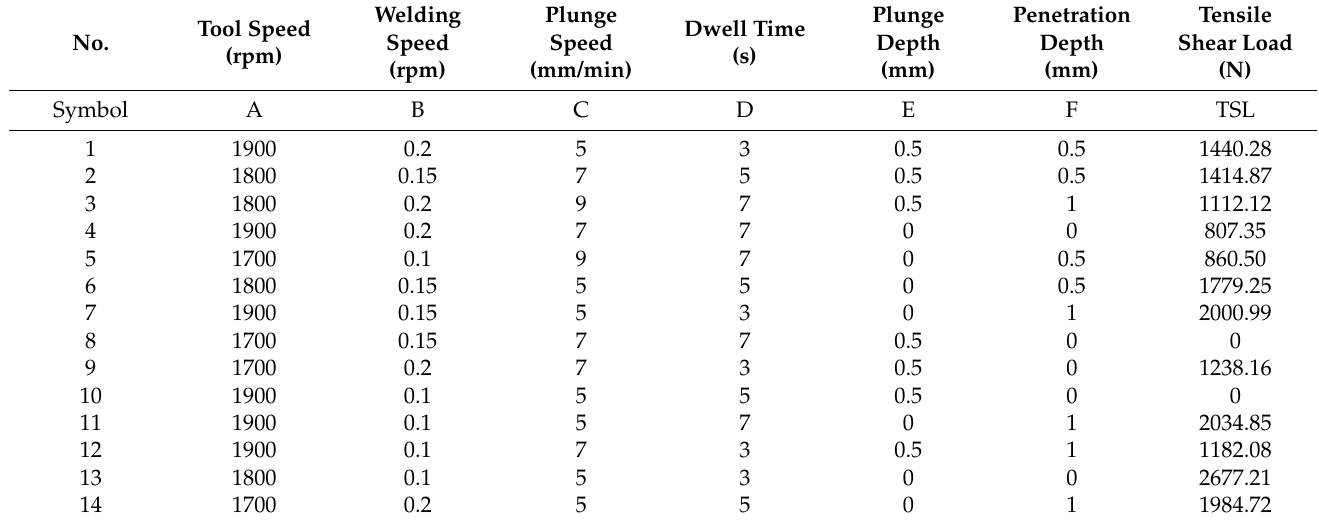
Table 3. Experiment level with run order.